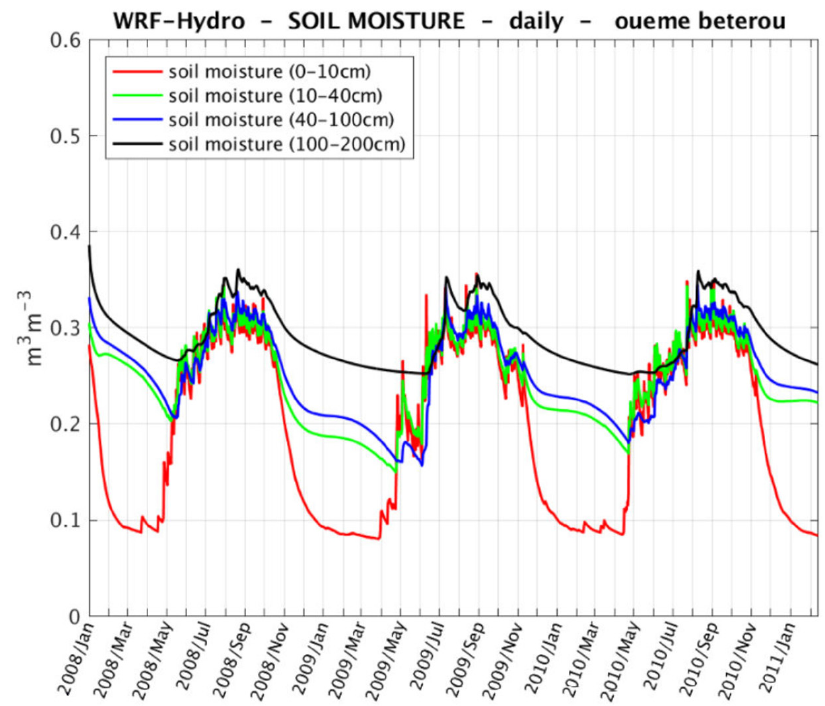
Figure 13. Daily average (five-day filtered) time series of soil water content (SWC) of the four Noah LSM soil layers of the WRF-H simulation at Bétérou.